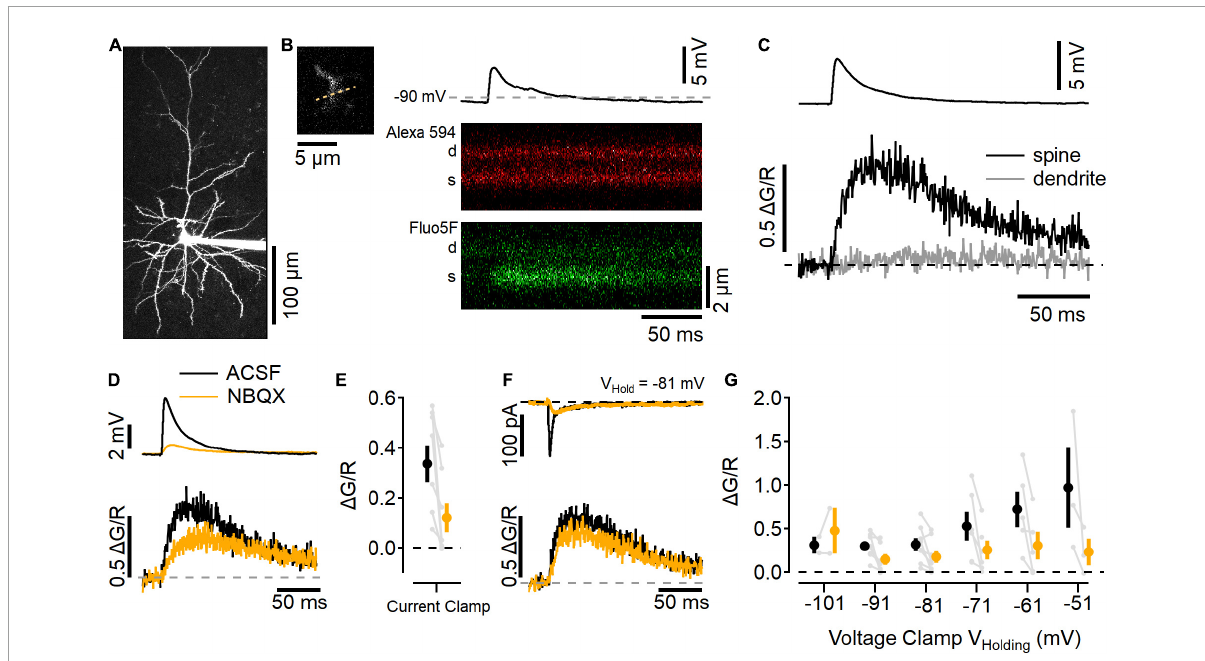
FIGURE5 Imaging Ca 2 + influx at individual L2/3 synaptic contacts. (A) Two-photon laser scanning image of a L2/3 neuron filled with 10 µ M Alexa 594 (maximum projection image). (B) Left, a dendritic segment and spine that was active after electrical stimulation in L4 was scanned repeatedly to generate line scan images, right. Example trial of a current-clamp recording (resting potential near –90 mV) with an EPSP elicited by stimulation (top), and line scans in the red channel (Alexa 594; middle), and green channel (Fluo-5F, 300 µ M; bottom) showing an increase in Ca 2 + -sensitive green fluorescence in the spine (s), but not the parent dendrite (d). (C) Image quantification of the synaptic response showing the change in green fluorescence from the baseline level before simulation, relative to the red fluorescence ( (cid:49) G/R, traces are an average of 10 trials). (D) Current-clamp measurements in “awake” ACSF (black) and after 10 µ M NBQX (orange) show NBQX reduces the EPSP (top) as well as Ca 2 + influx into the spine (bottom). (E) Summary of eight current-clamp recordings before and after NBQX application (individual experiments are shown in gray, black symbol is mean ± SEM in ACSF, and the orange symbol is the mean ± SEM in NBQX). (F) Example voltage-clamp recording holding at –81 mV shows synaptic currents (top) and Ca 2 + transients (bottom) before (black) and after (orange) NBQX application. (G) Summary of synapse imaging experiments performed in voltage clamp at different holding potentials [ N = 2–8 recordings at each voltage, symbols as in (E) ].